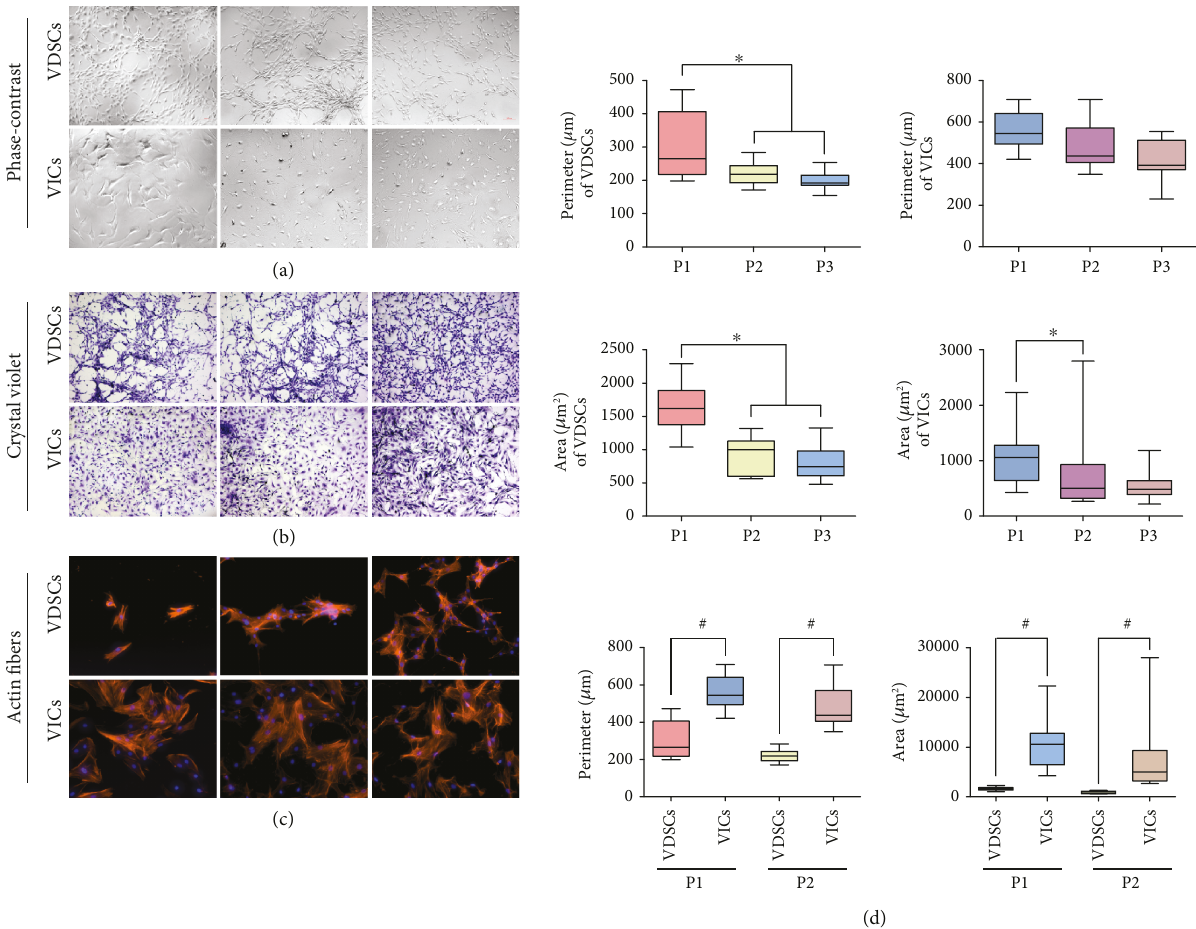
Figure 1: Cell morphology comparison between valve-derived stromal cells (VDSCs) and valve interstitial cells (VICs). (a) Phase-contrast images of VDSCs and VICs (passages 1 to 3: P1 to P3), (b) VDSCs and VICs with crystal violet staining, and (c) immuno fl uorescence staining of cellular actin stress fi bers with rhodamine phalloidin and nuclei were stained with DAPI. (d) Quantitation of cell area ( μ m 2 ) and cell perimeter ( μ m) comparison between VDSCs and VICs, ∗ , # p < 0 05 are accepted as have signi fi cant di ff erence, n = 12